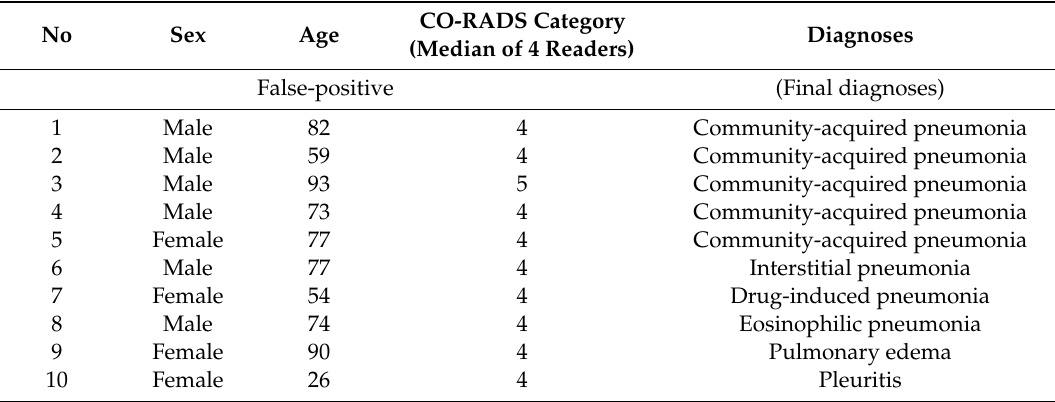
Figure 6. Example of a false-positive case (Case 1). Seventy-four-year-old male. The CT images show bilateral ground-glass opacities distributed peripherally to centrally with a right lung predominance. RT-PCR was negative for SARS-CoV-2. She had a history of eosinophilic pneumonia and was diagnosed with relapse of eosinophilic pneumonia. Readers 1, 2, 3, and 4 diagnosed it as Categories Table 6. Characteristics of false-negative cases in chest CT. 3, 4, 4, and 3, respectively. CT, computed tomography; RT-PCR, reverse transcription-polymerase chain reaction; SARS-CoV-2, severe acute respiratory syndrome coronavirus 2.